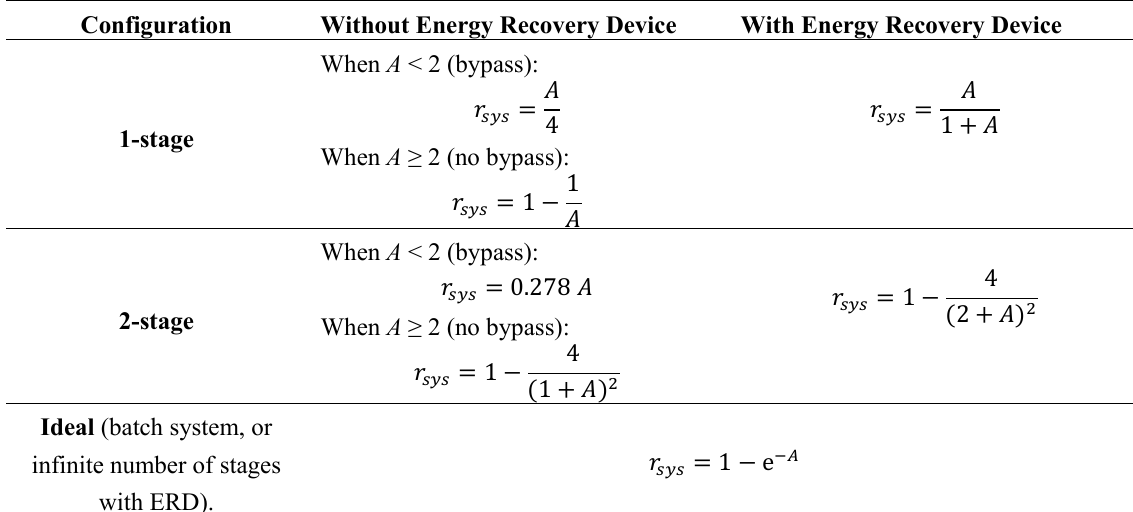
Table 1. Expressions for upper limit to system recovery ratio r sys according to RO configuration, as a function of dimensionless parameter A defined by Equation (9), based on semi-ideal theoretical SEC sideal taking into account only essential losses. With a batch system, (or infinitely many stages) the ideal case Equation (8) is reached. In all cases, the system is assumed driven by a reversible heat engine with work output given by Equation